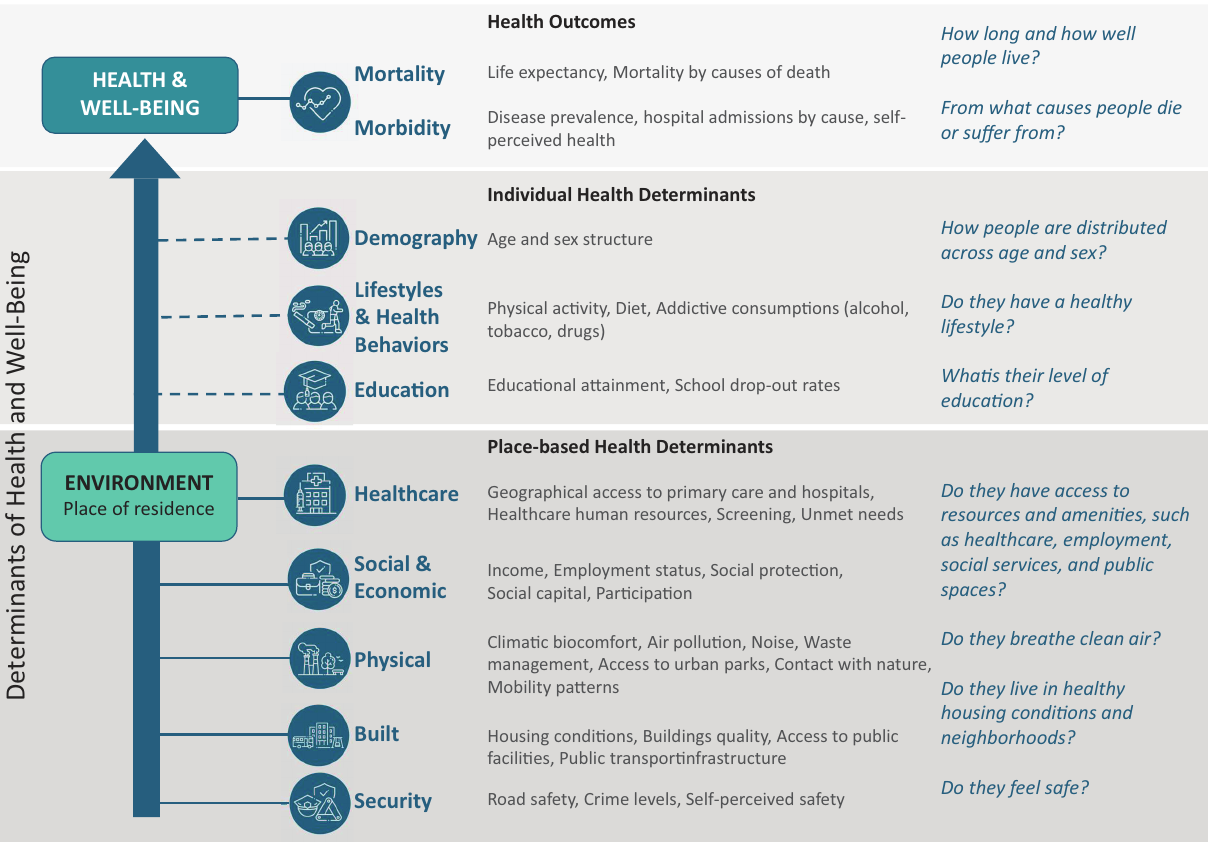
Figure 3. The multidimensional framework of health assessment applied in the MHS of Coimbra. Note: the list of indicators is provided in Supplementary File 2. Source: Authors’ work adapted from Câmara Municipal de Coimbra and Universidade de Coimbra